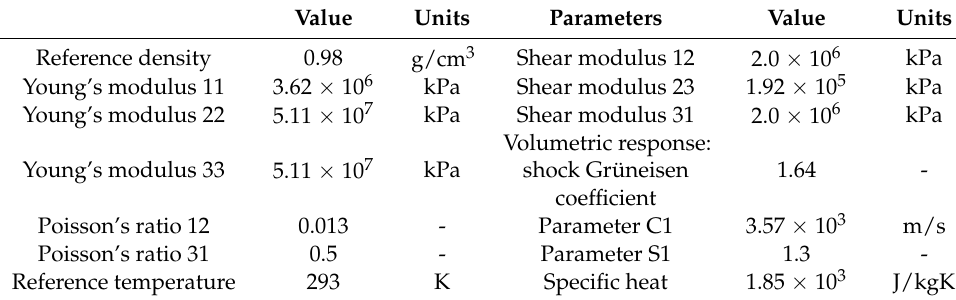
Table 6. Material constants for Orthotropic equation of state.